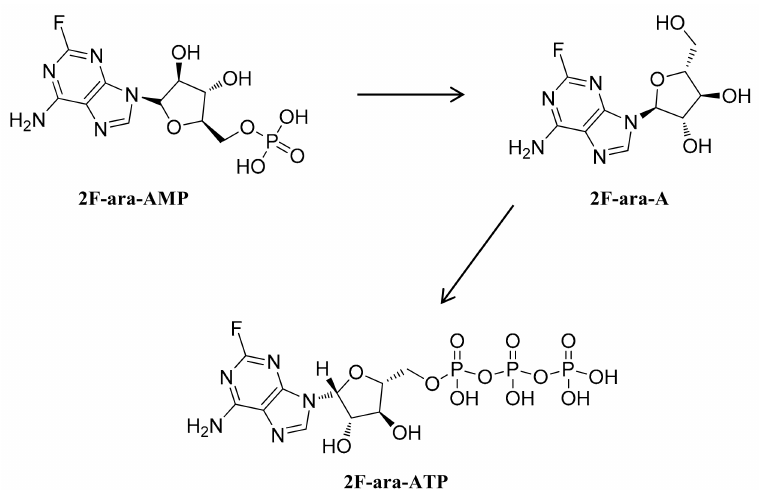
Figure 1. Activation of fludarabine. Fludarabine phosphate (2F-ara-AMP) is dephosphorylated to 9-P-D-arabinofuranosyl-2-fluoroadenine (Fludarabine, 2F-ara-A) in serum, which is taken up by cells. Upon entry into cells, 2F-ara-A is phosphorylated by deoxycytidine kinase to the pharmacologically active form, fludarabine triphosphate